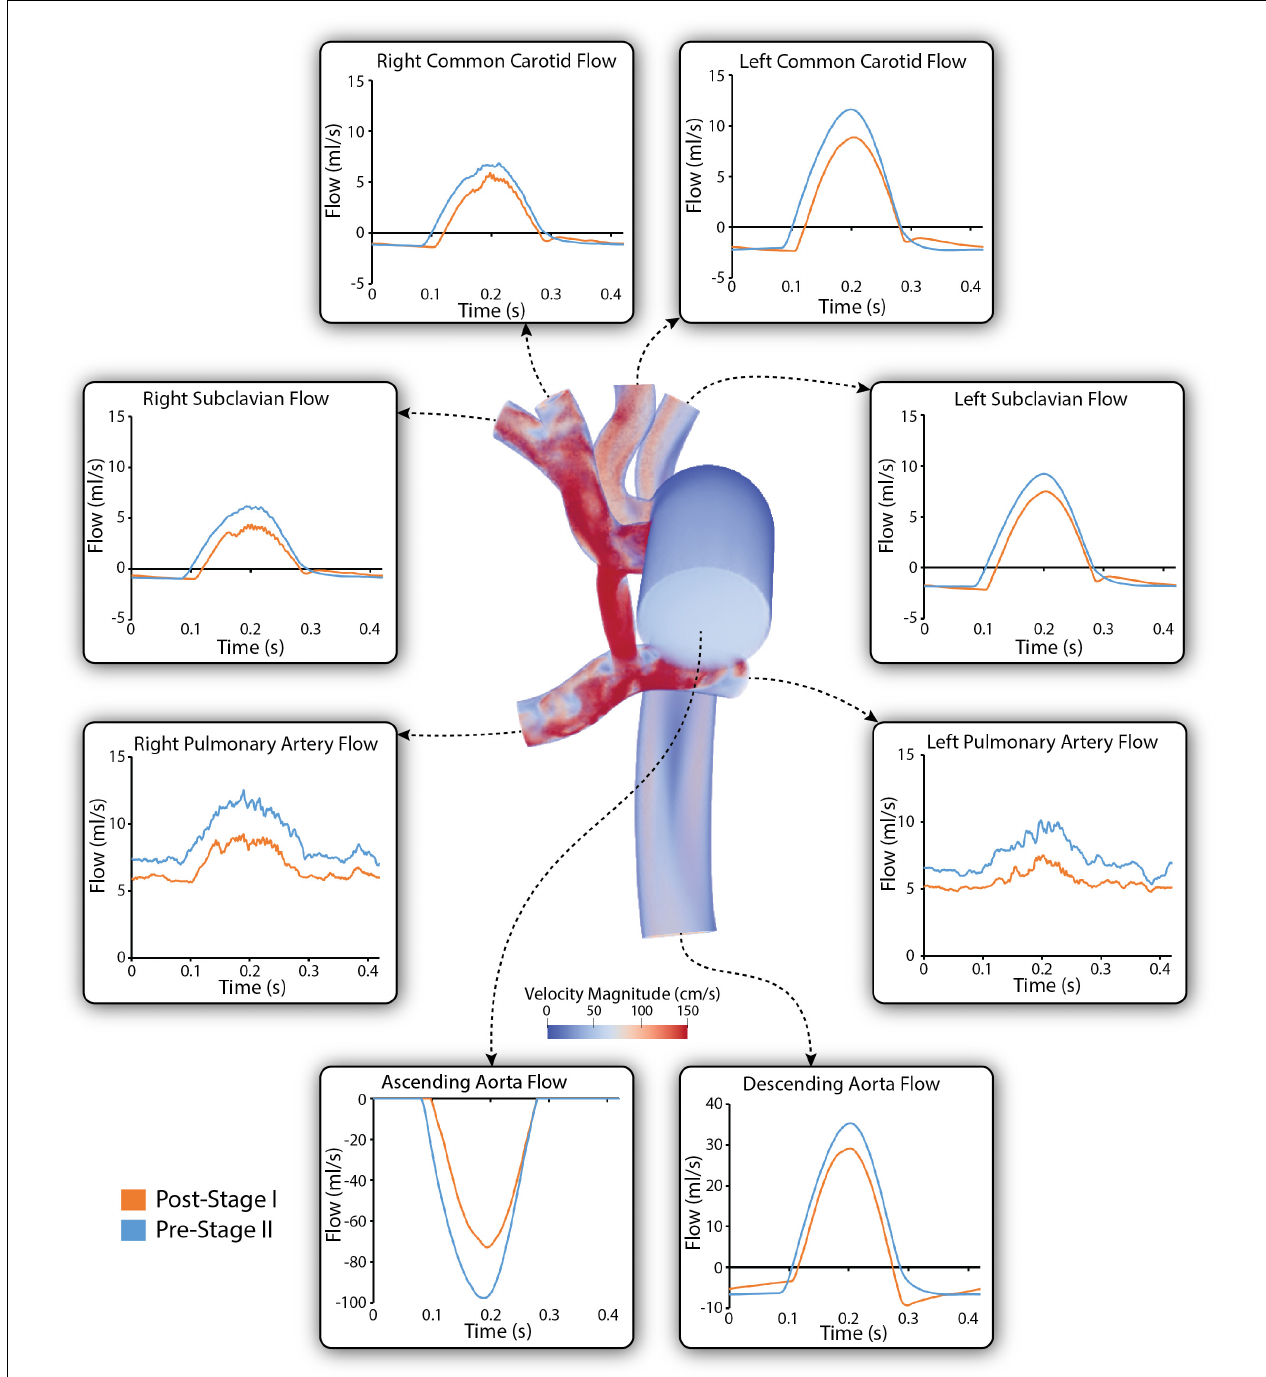
FIGURE 6 | Simulated pulsatile flow waveforms at all boundaries of the 3D domain for both post-S1 (orange) and pre-S2 (blue) models. All outflows are plotted as positive and all inflows are plotted as negative. Note that three different y -axis scales have been used: one for the descending aorta, another for the ascending aorta and a third for the remainder of the outlets. A volume rendering of velocity magnitude for the pre-S2 model is shown during peak-systole ( t = 0.21 s).